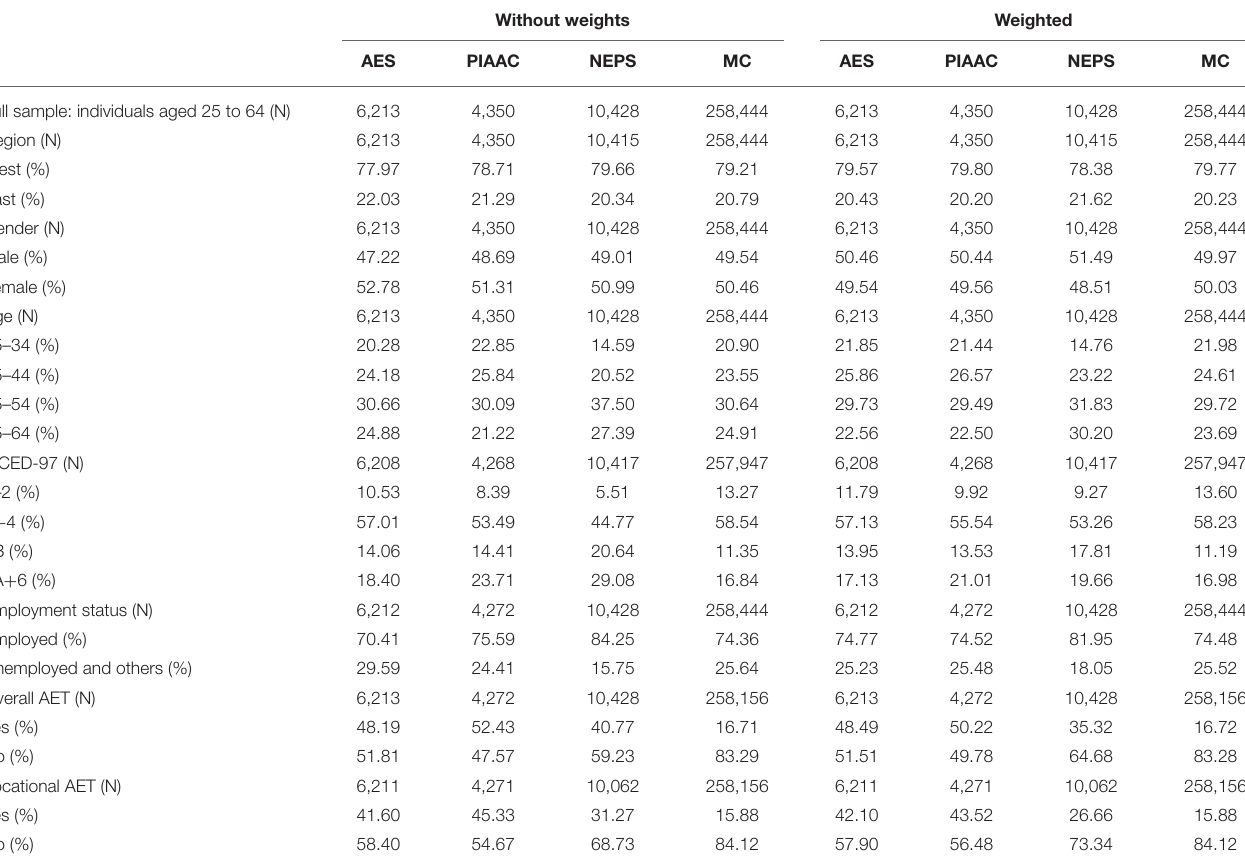
TABLE 4 | Sample characteristics of AES, PIAAC, NEPS, and